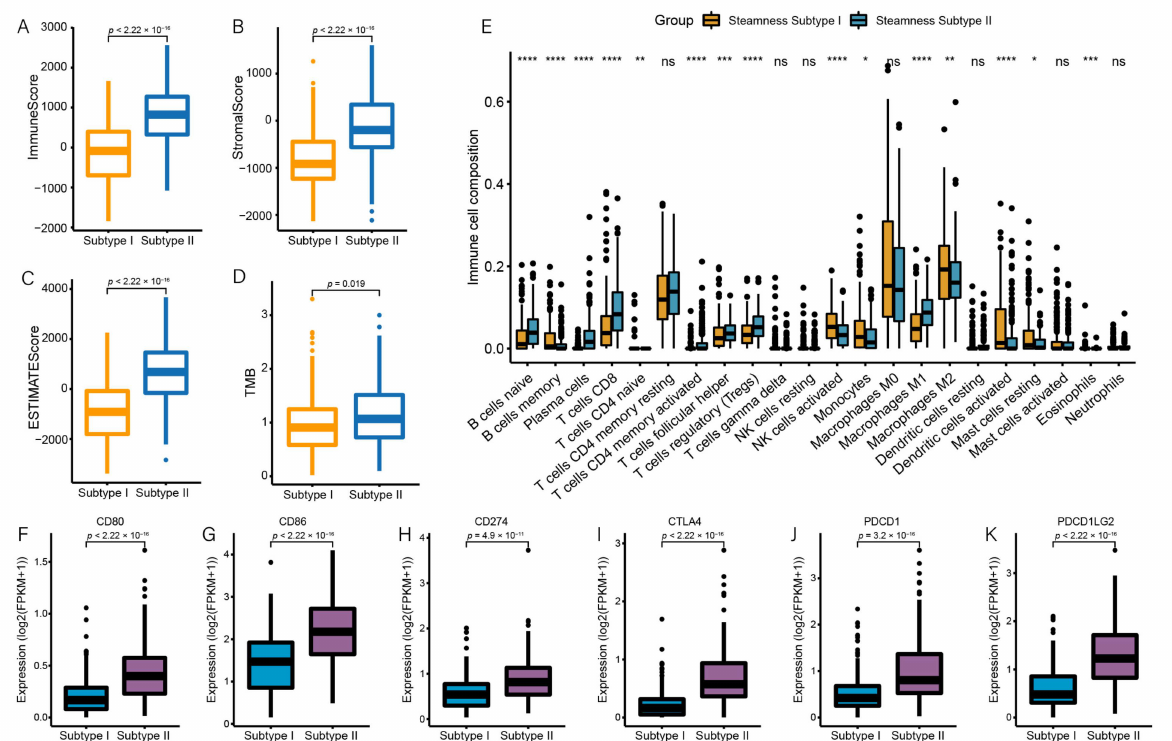
Figure 5. The two stemness subtypes exhibit distinct differences in immune infiltration. ( A – D ) Com- parisons of the immune score, stromal score, ESTIMATE score, and TMB between the stemness subtypes I and II. ( E ) Comparisons of the abundances of 22 immune cells in the 2 subtypes. ( F – K ) The expression levels of PDCD1 , PDCD1LG2 , CD274 , CTLA4 , CD86 , and CD80 in the two subtypes. * p < 0.05; ** p < 0.01; *** p < 0.001, **** p <